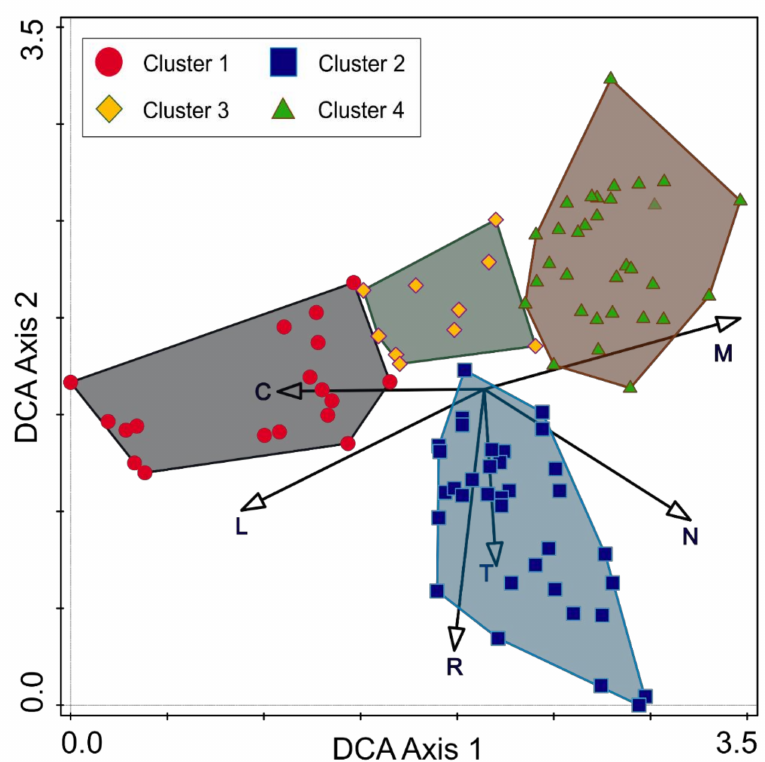
Figure 2. The passive projection of Ellenberg indicator values (EIVs) into the DCA ordination diagram of differentiation of forest communities on serpentinites of SW Poland. Gradient length = 3.46 SD units. Total variation was 5.81, supplementary variables accounted for 19.51% (adjusted explained